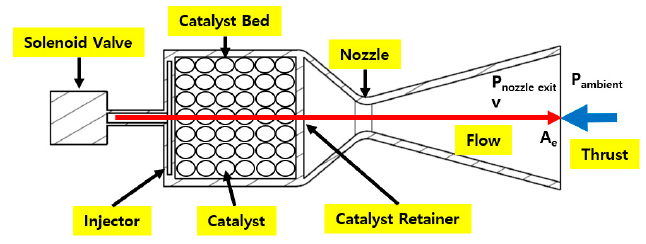
Figure 1. Typical monopropellant thruster.